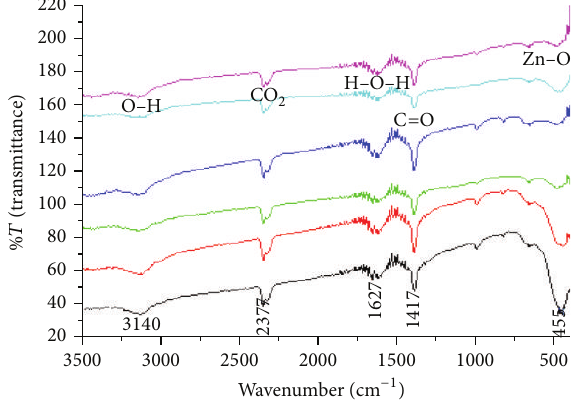
Figure 3: FTIR spectra of Zn 0.9 Co 0.1−𝑥 Cd 𝑥 O ( 𝑥 = 0.0, 0.02, 0.04, 0.06, 0.08, and 0.1).